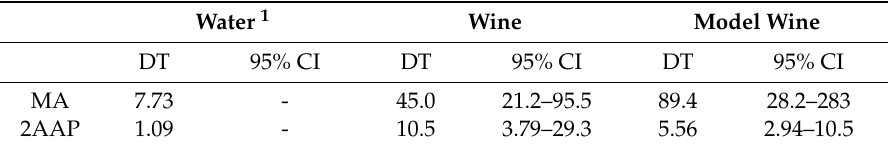
Table 4. Mean Detection Thresholds ( µ g/L) across All Matrices.